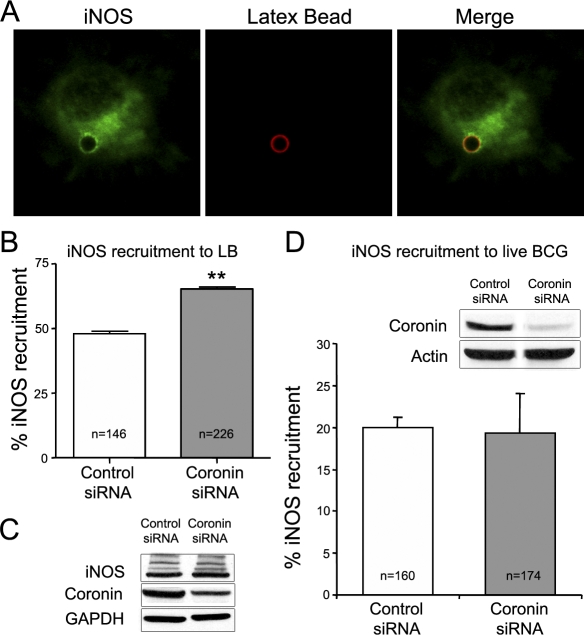
Knockdown of Coronin-1 Increases Localization of iNOS to Model Latex Bead Phagosomes but Not on Live Mycobacteria PhagosomesMacrophages were transfected with either control (scramble) or coronin-1 siRNA, stimulated with IFN-γ and LPS for 16 h the following day, and then incubated with Alexa 568–labeled latex beads or Alexa 568 live mycobacteria for 10 min. After phagocytosis followed by 1-h chase, cells were fixed, stained for iNOS, and examined by confocal microscopy.(A) Localization of iNOS (green) to latex bead phagosomes (red).(B) Quantification of iNOS recruitment to latex bead phagosomes. Bars, mean ± s.e.m. (three independent experiments); n, number of phagosomes counted per condition. **
p < 0.0001.(C) Western blot of coronin-1 and loading control (GAPDH) after 48 h (includes IFN-γ and LPS stimulation) for (A and B).(D) Quantification of iNOS recruitment to live mycobacteria phagosomes. Bars, mean ± s.e.m. (three independent experiments); n, number of phagosomes counted per condition. p > 0.05. Inset: western blot of coronin-1 and actin (loading control).